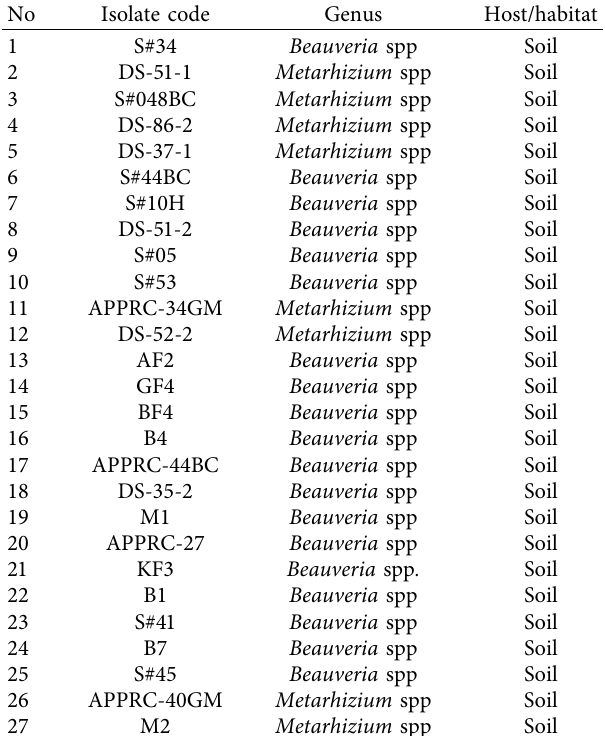
Table 1: List of entomopathogenic fungi (EPF) isolates used for the